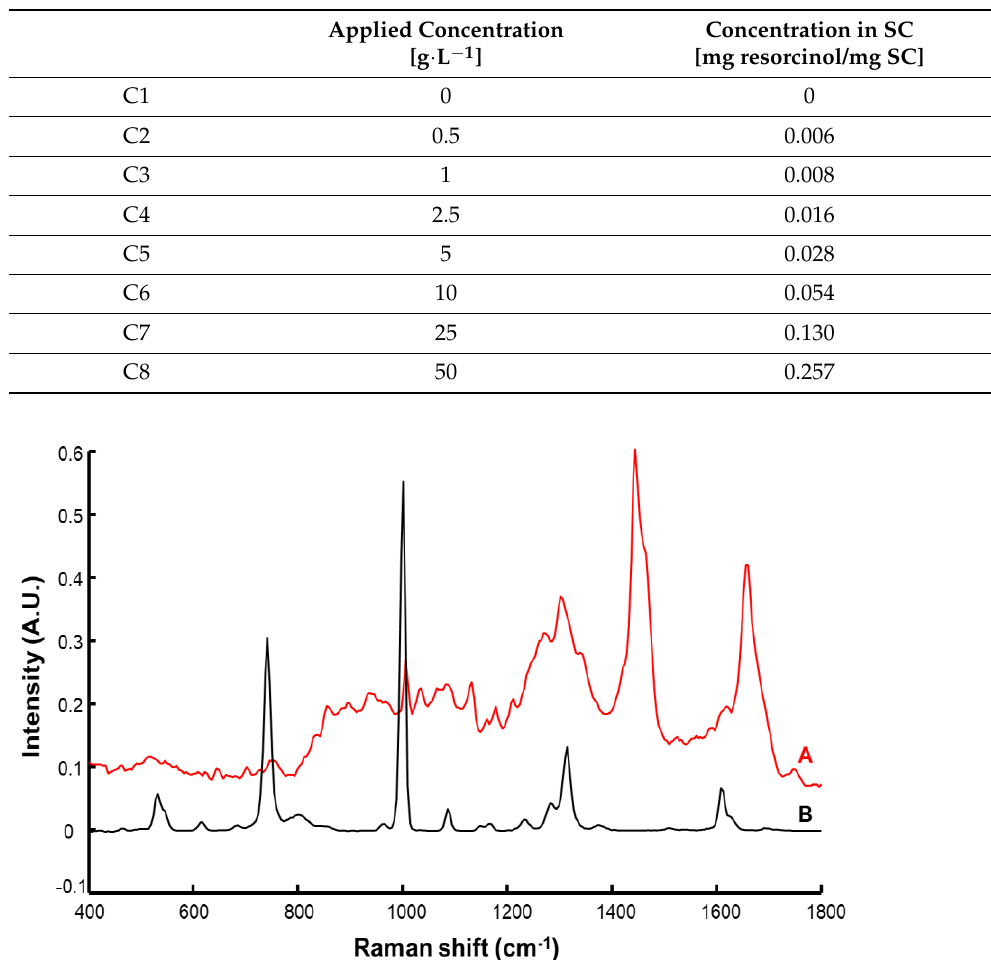
Figure 2. Linear regression of concentration in SC against resorcinol concentrations used as immersion medium. Table 1. Calculated reference concentrations in SC for samples analysed by CRM.